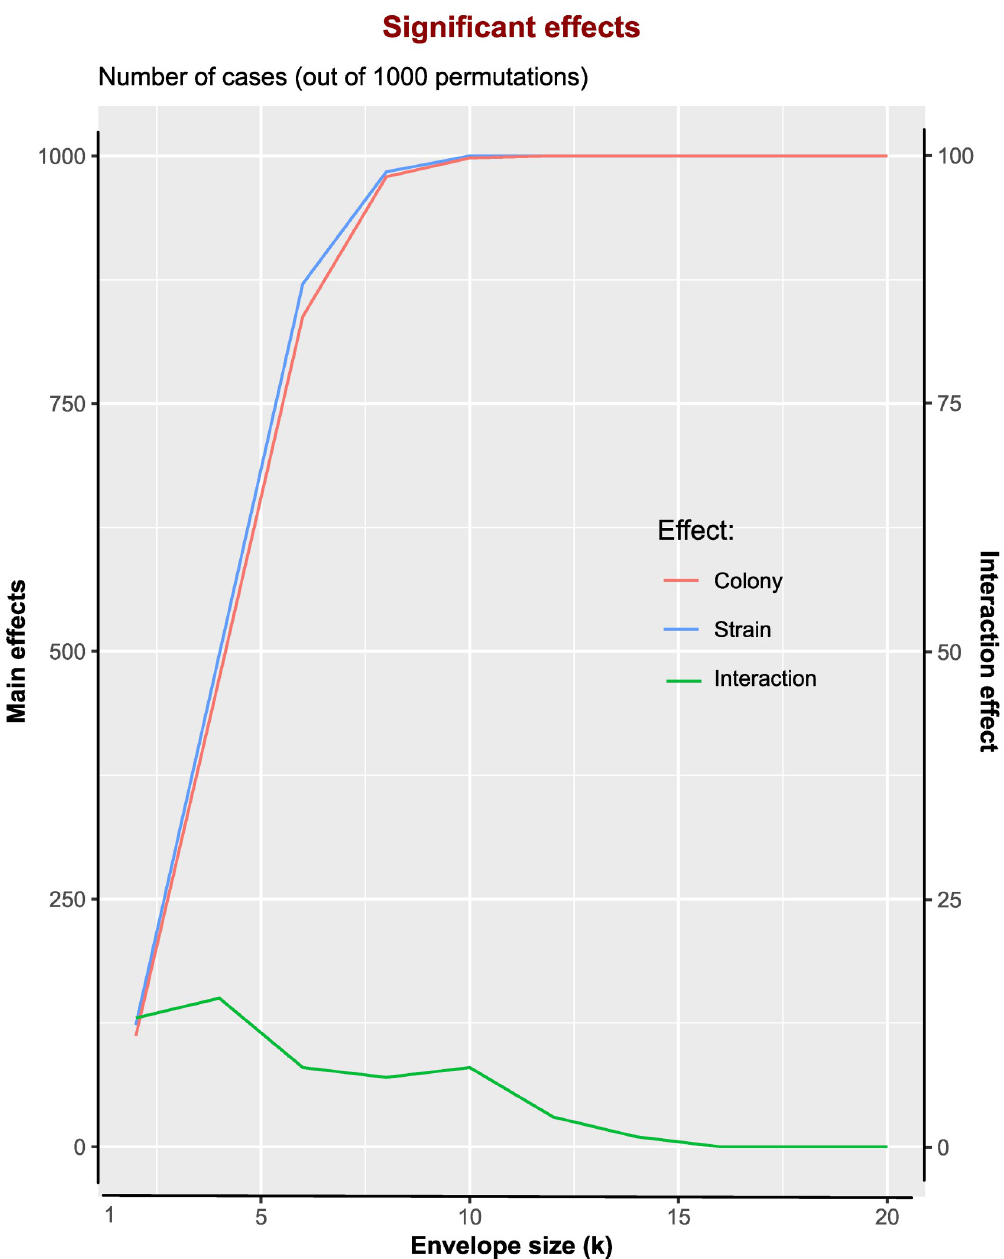
Fig 6. Prevalence of significant effects. Shown are the number of cases in relation to envelope size (k), and per 1,000 random permutations, where either the main effects for Colony or Strain, or the Interaction effects became significant (at level, p crit = 0.01) in ANOVAs. Envelope size k defines the size of the analysed matrix (k x k). Infection intensity was transformed with exp = 1/3 to normalize variances. Here, all cases (incl. bees with zero infection) were used.